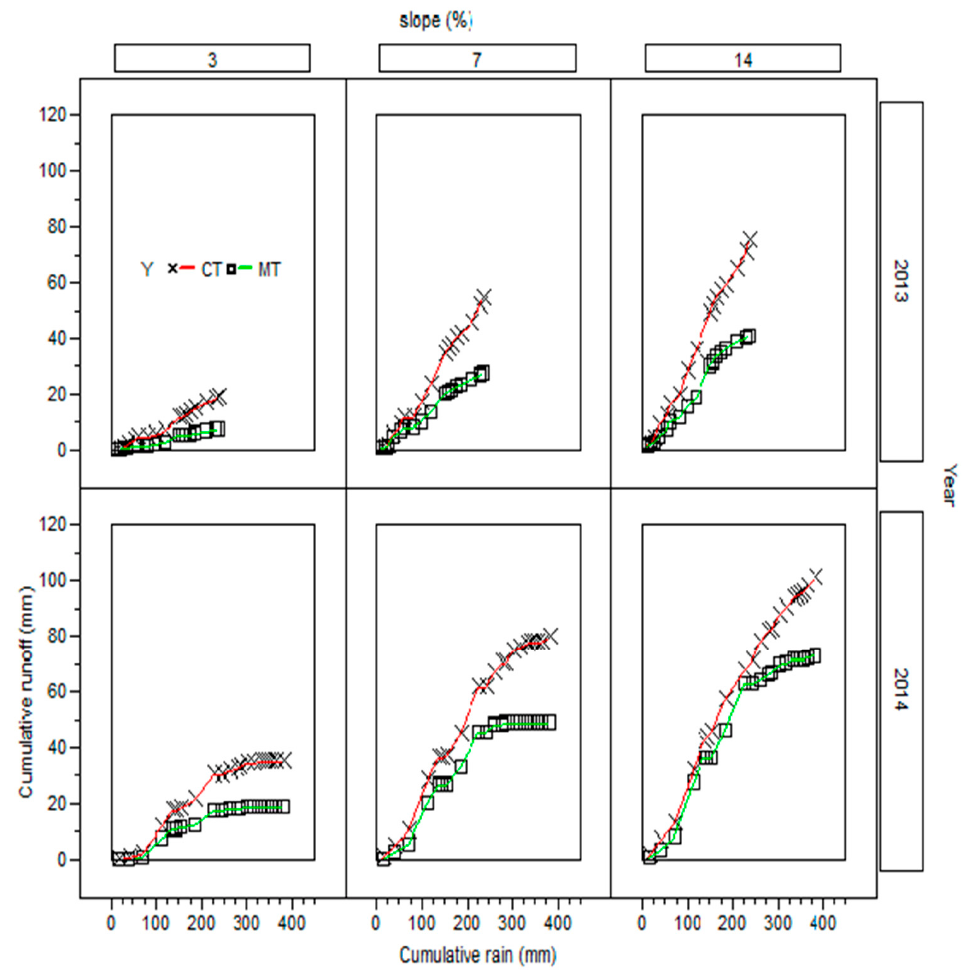
Figure 5. Cumulative surface runoff from conventional tillage (CT) and locally adapted conservation tillage (MT) maize planted in 14%, 7%, and 3% slope plots at Bolo Silase, Ethiopia.